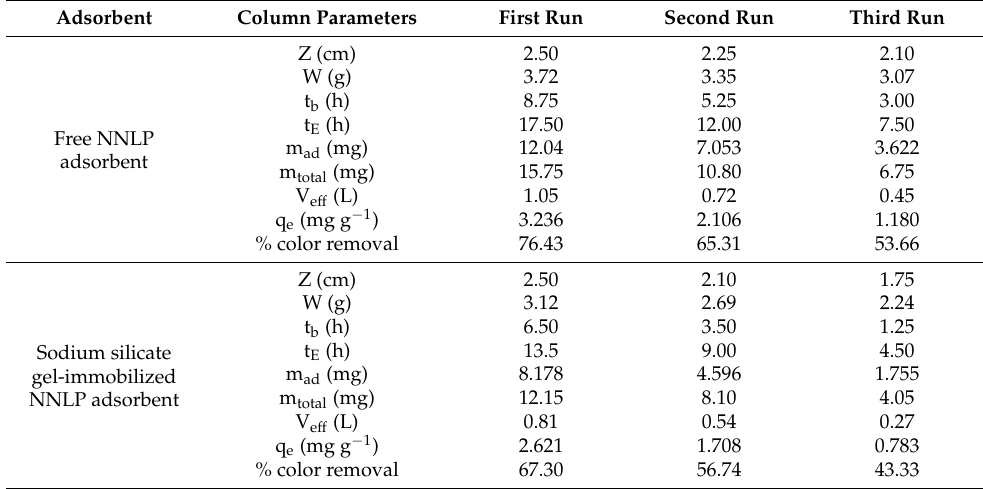
Table 3. Column experimental parameters obtained at various runs for the decolorization of CR dye onto free and immobilized NNLP